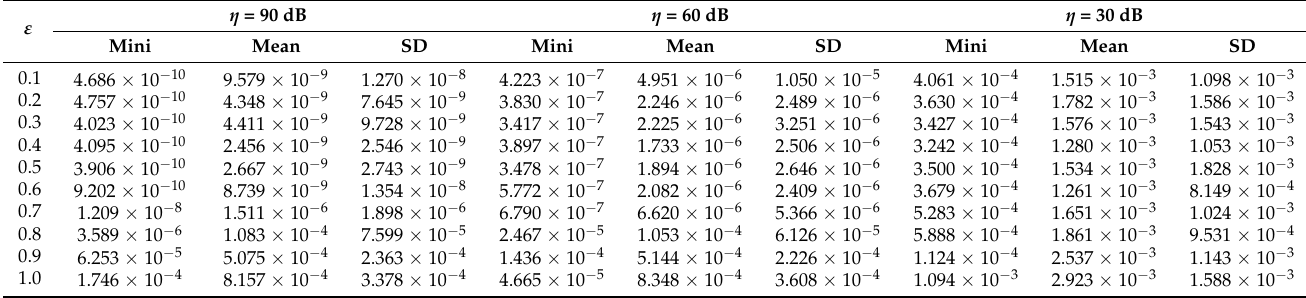
Table 4. Results of statistical measures for all considered ε and η